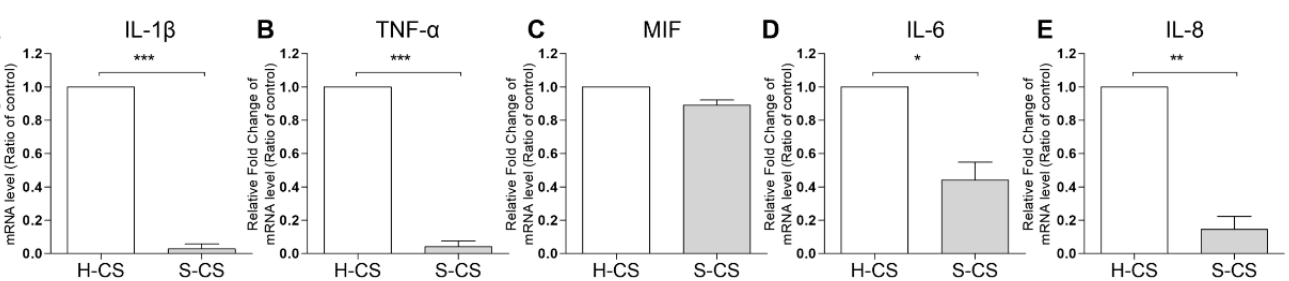
Figure 3. Comparison of the concentrations of humoral factors secreted by heterogeneous chondrocyte sheets (H-CS) and stratified chondrocyte sheets (S-CS). To determine the humoral factors’ expression levels, the cell culture medium was collected at 72 h after triple layer sheets were fabricated. The protein levels of ( A ) TGF- β 1, ( B ) MMP13, ( C ) MMP3, ( D ) TIMP-1, and ( E ) TIMP-3 were measured as Material and Methods described. Data are presented as bar with median concentration. (*, p < 0.05).